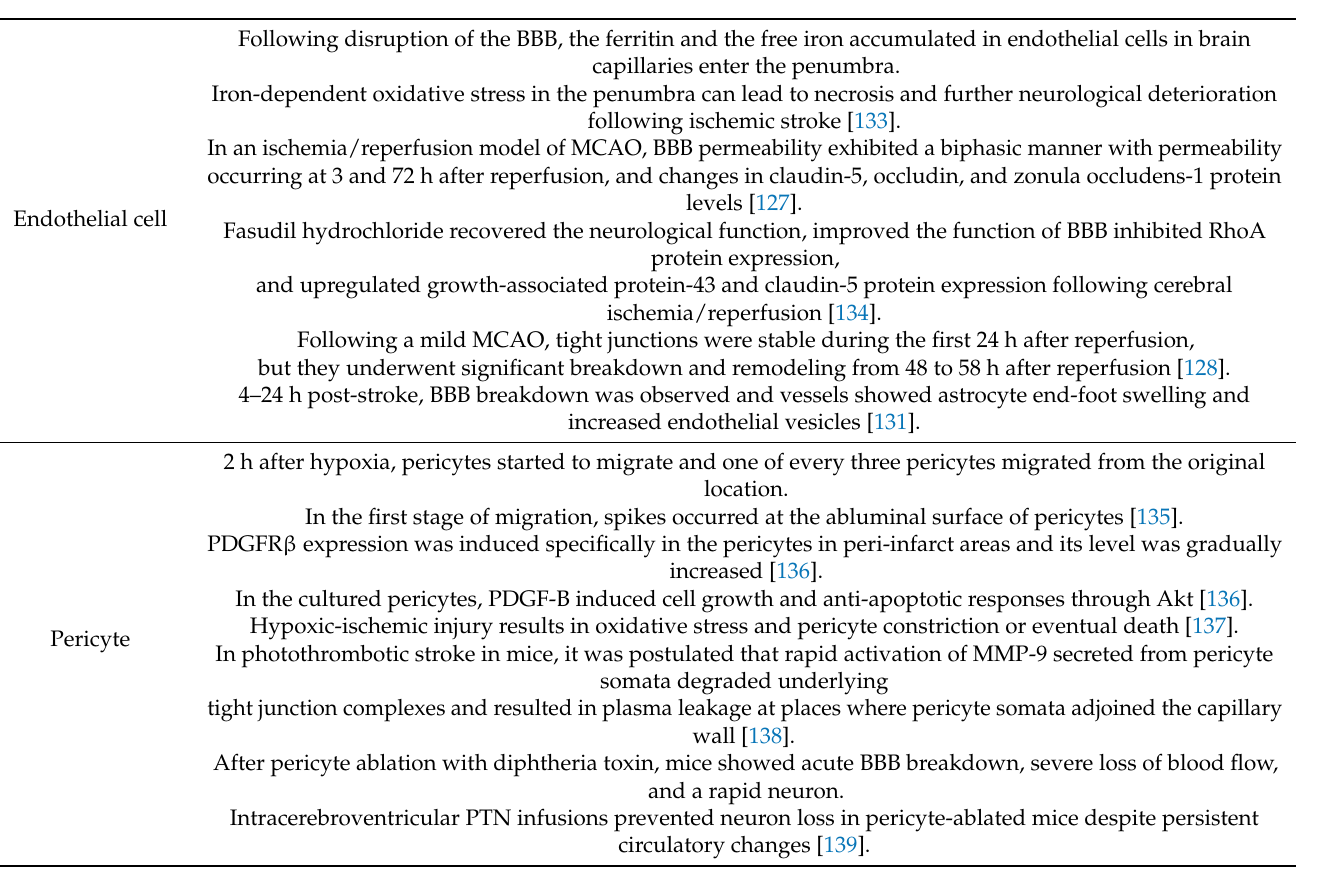
Table 1. Remodeling of NVU after ischemic